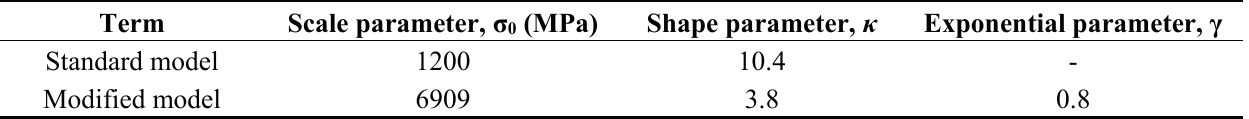
Table 5. Weak-link Weibull estimates for tensile strength in the fiber radial direction.